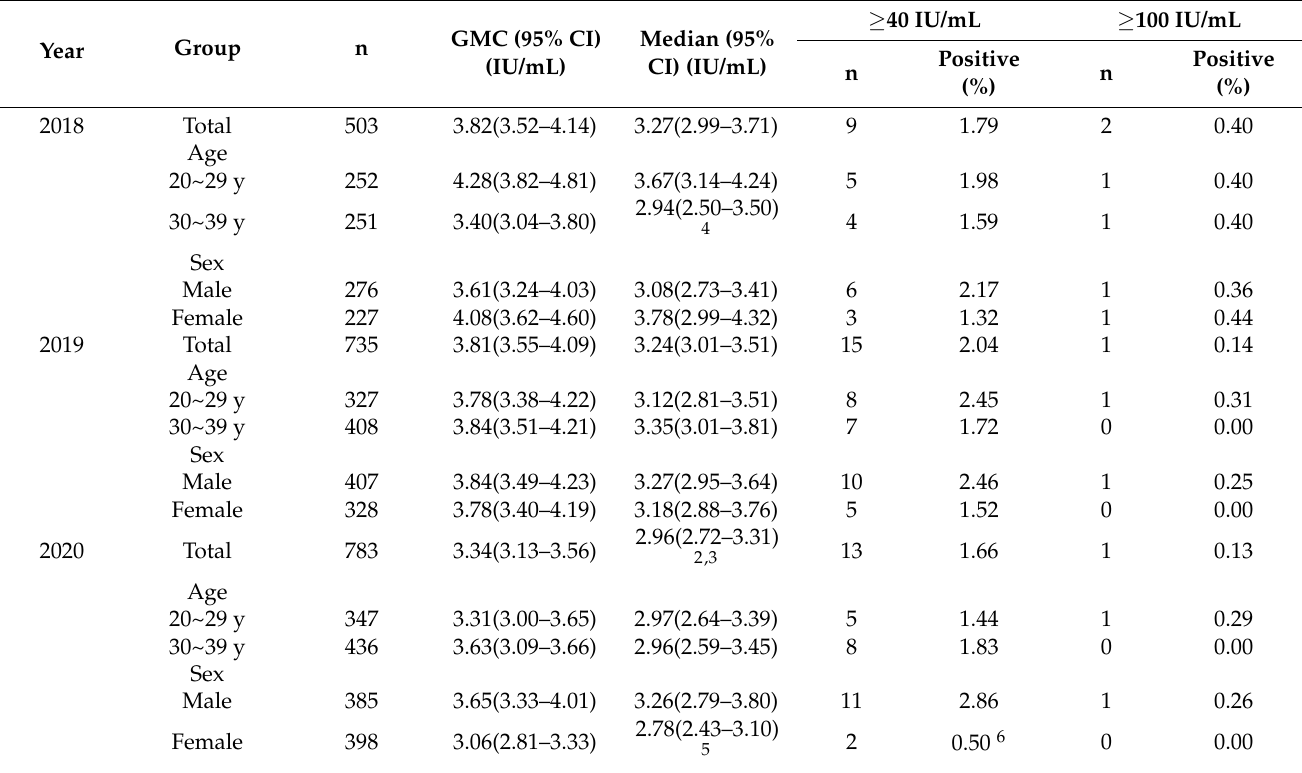
Table 1. The concentration and positivity rate of anti-PT IgG antibodies between genders in adults aged 20~39 years, Beijing, China, 2018~2020. (n = 2021) 1